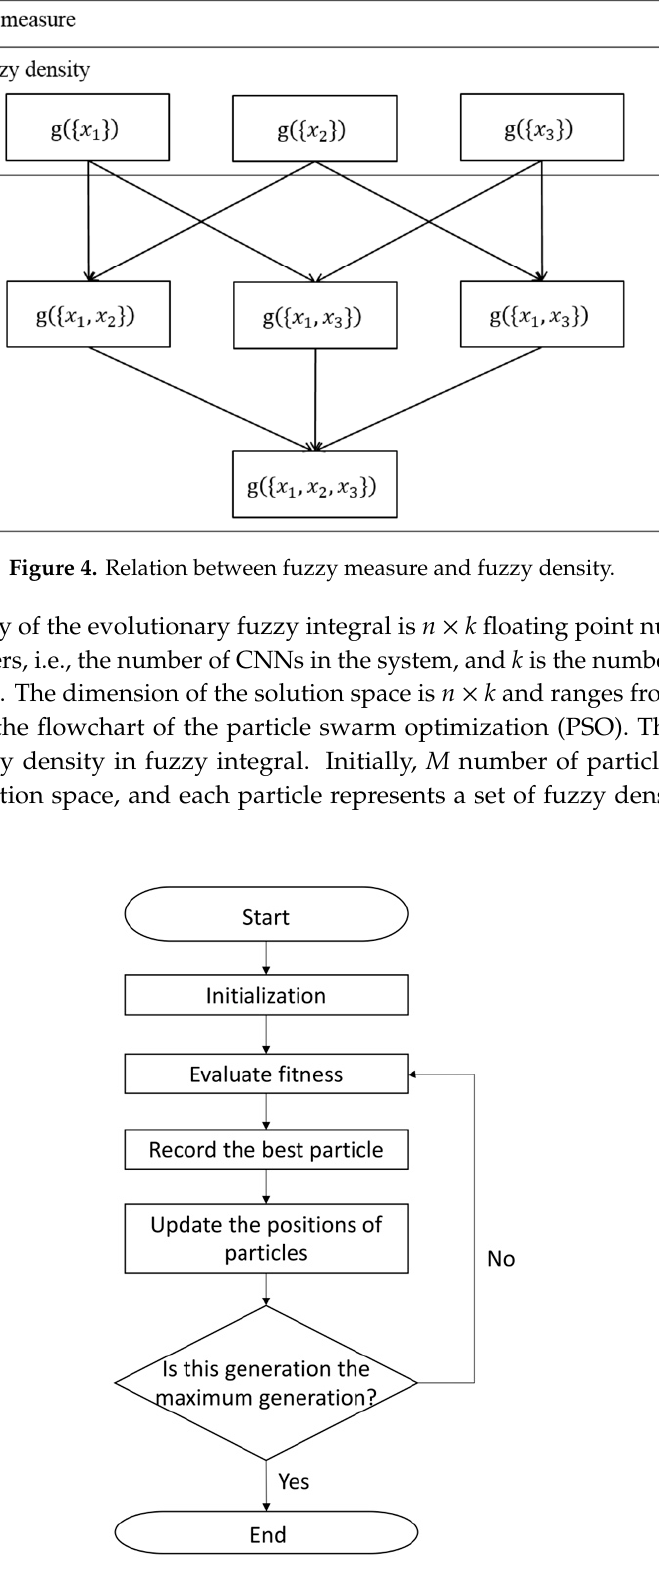
Figure 4. Relation between fuzzy measure and fuzzy density.